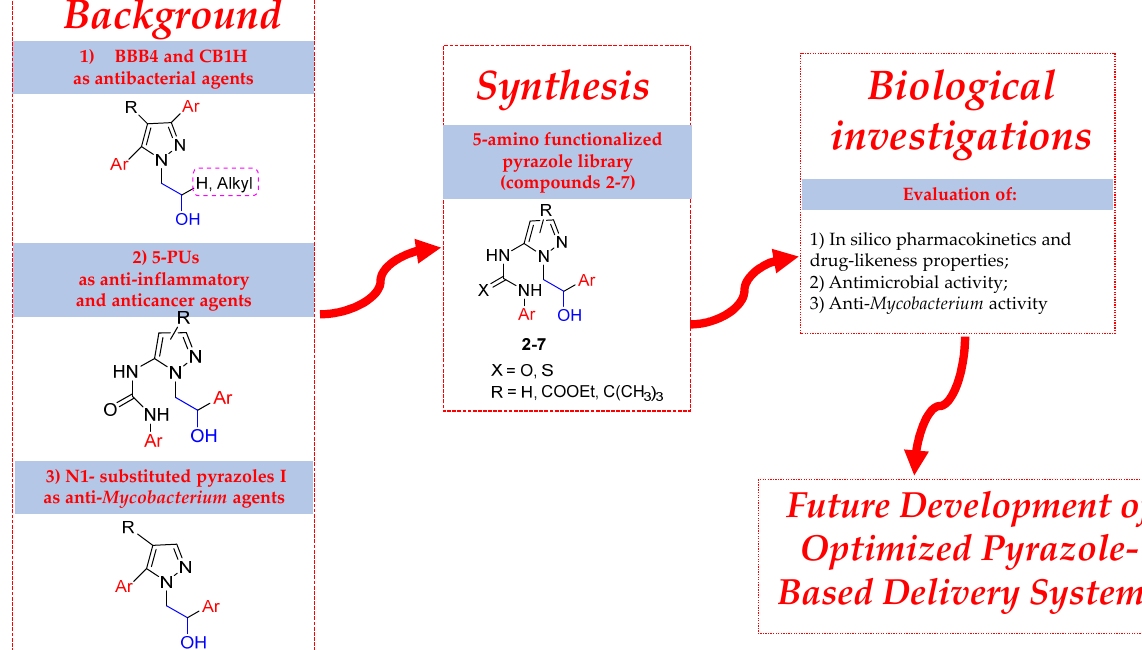
Figure 2. Workflow of the applied strategies leading to the design, biological evaluation and future development of novel pyrazole compounds 2 – 7 . Table 1. Chemical structure, melting point and reaction yield of new pyrazole derivatives 2 – 7 .